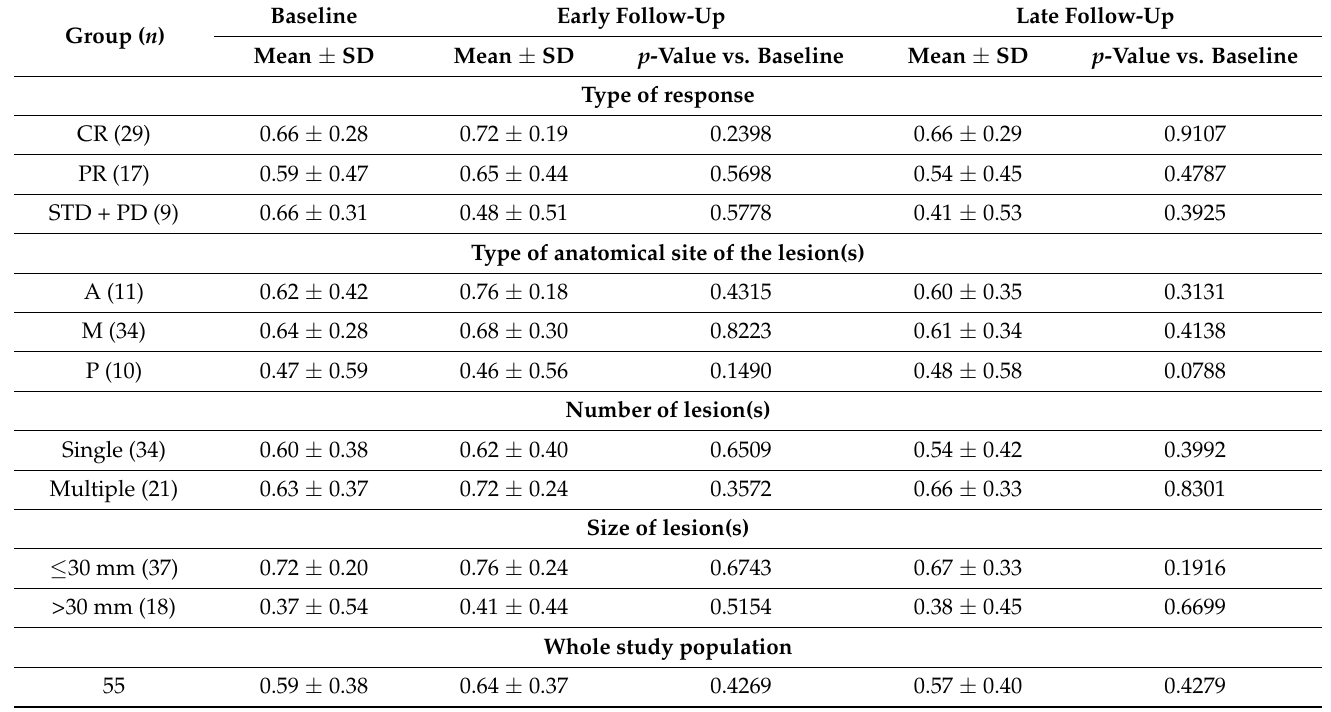
Table 3. EuroQol 5-Dimension